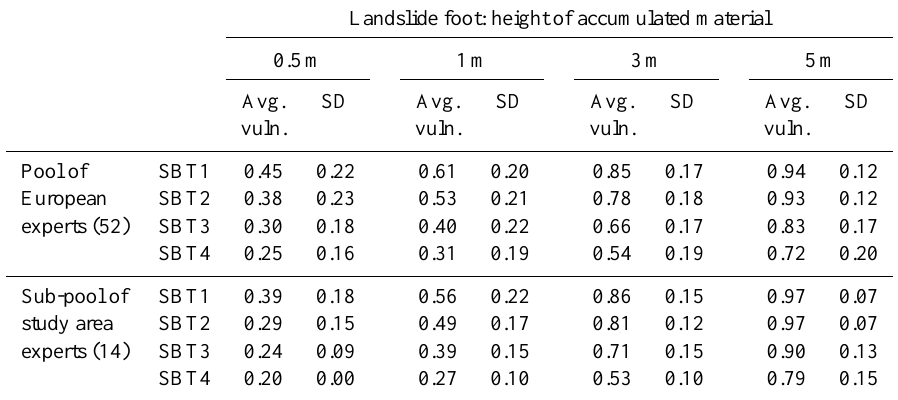
Table 8. Average vulnerability and standard deviation for each structural building type located on a landslide foot (cf. Table 1 for building type). Landslide foot: height of accumulated material 0.5m 1m 3m 5m Avg. SD Avg. SD Avg. SD Avg. SD vuln. vuln. vuln. vuln. Pool of SBT1